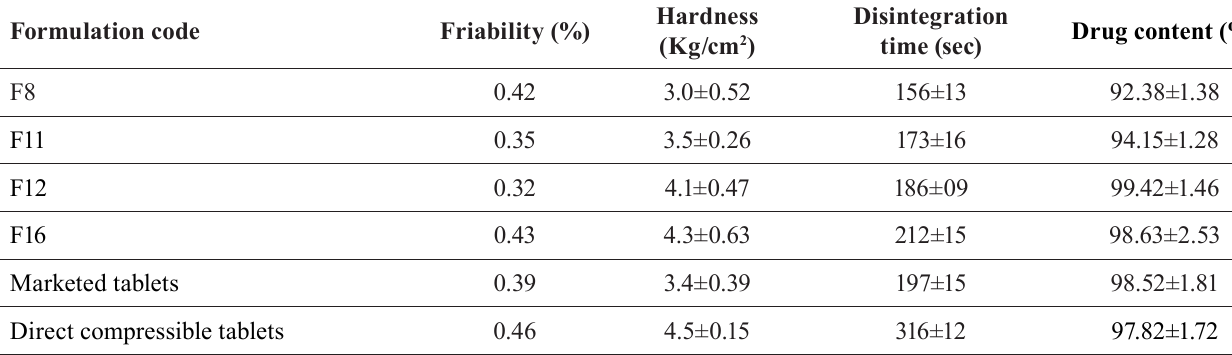
TABLE IV - Evaluation of racecadotril liquisolid tablets (Mean ±